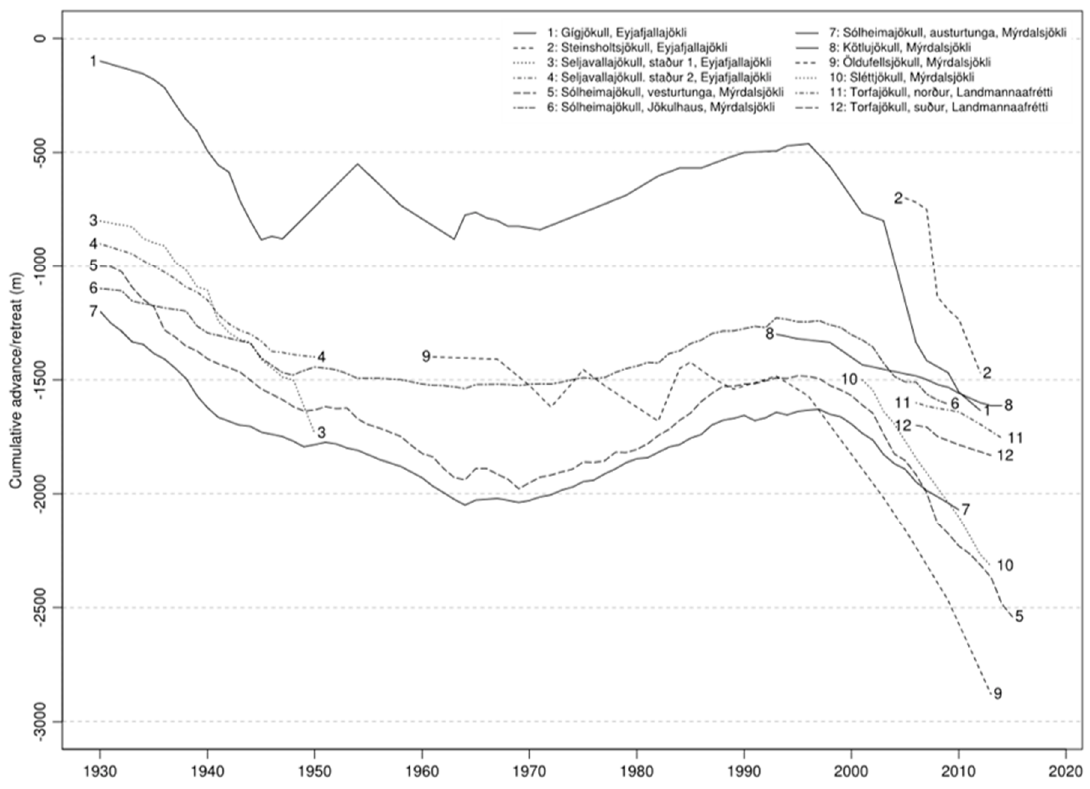
Figure 2. Glacier oscillations for selected snouts of Mýrdalsjökull and adjacent snouts (compiled by the Icelandic Glaciological Society). Note that Oldufellsjökull has been monitored since 1960 but no records exist for Sandfellsjökull.